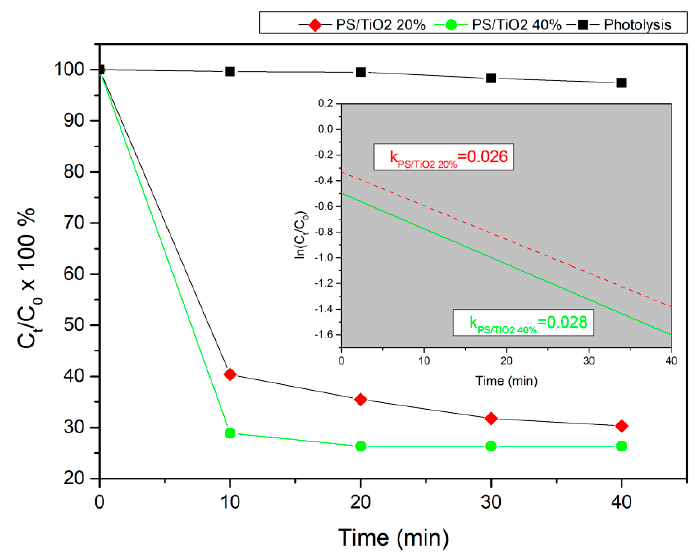
Figure 4. Percentage (%) acetaminophen (APAP) degradation using 20% w/w and 40% w/w [red solid rhombuses and green solid circles] TiO 2 -based 3D-printed nanocomposites under ultraviolet (UV-A) irradiation, vs. irradiation time, respectively. For comparison reasons, the photolysis curve (black solid squares) is also presented. In the inset one can see the apparent rate constants (k) of APAP degradation using 20% w/w and 40% w/w 3D printed TiO 2 /PS nanocomposite photocatalysts.